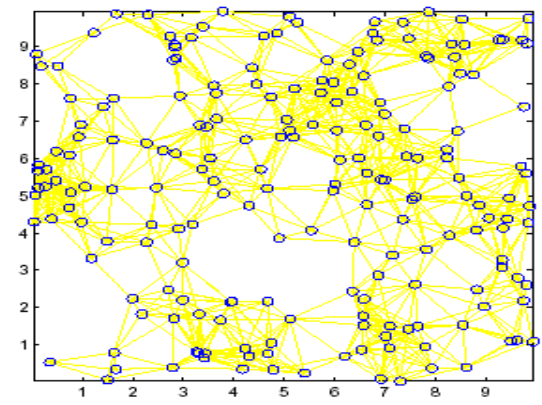
Figure 10. Simulation